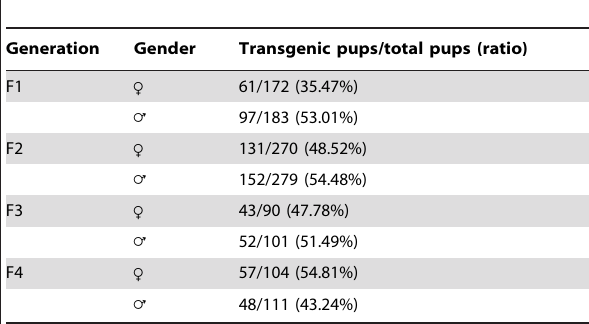
Table 2. Transmission of pFSH a and pFSH b BAC transgenes in TG 6 WT